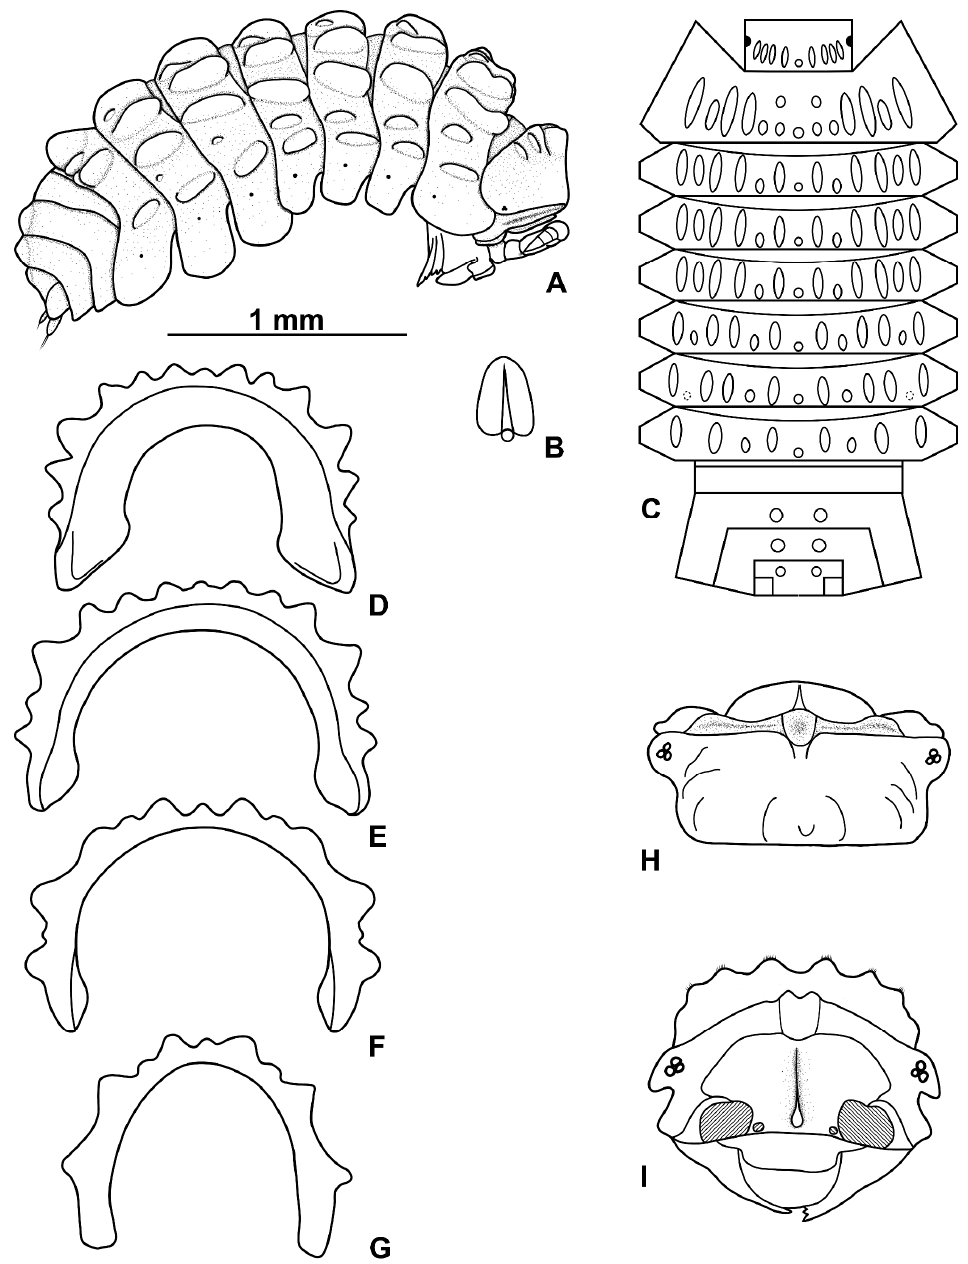
Figure 1. Buddelundiella zoiai sp. n., paratype ♀ from Murialdo. ( A ) Specimen in lateral view. ( B ) Dorsal scale-seta. ( C ) Disposition of dorsal tubercles. ( D ) Pereonite 1, caudal view. ( E ) Pereonite 2, caudal view. ( F ) Pereonite 6, caudal view. ( G ) Pereonite 7, caudal view. ( H ) Cephalon, dorsal view. ( I ) Cephalon, frontal view.